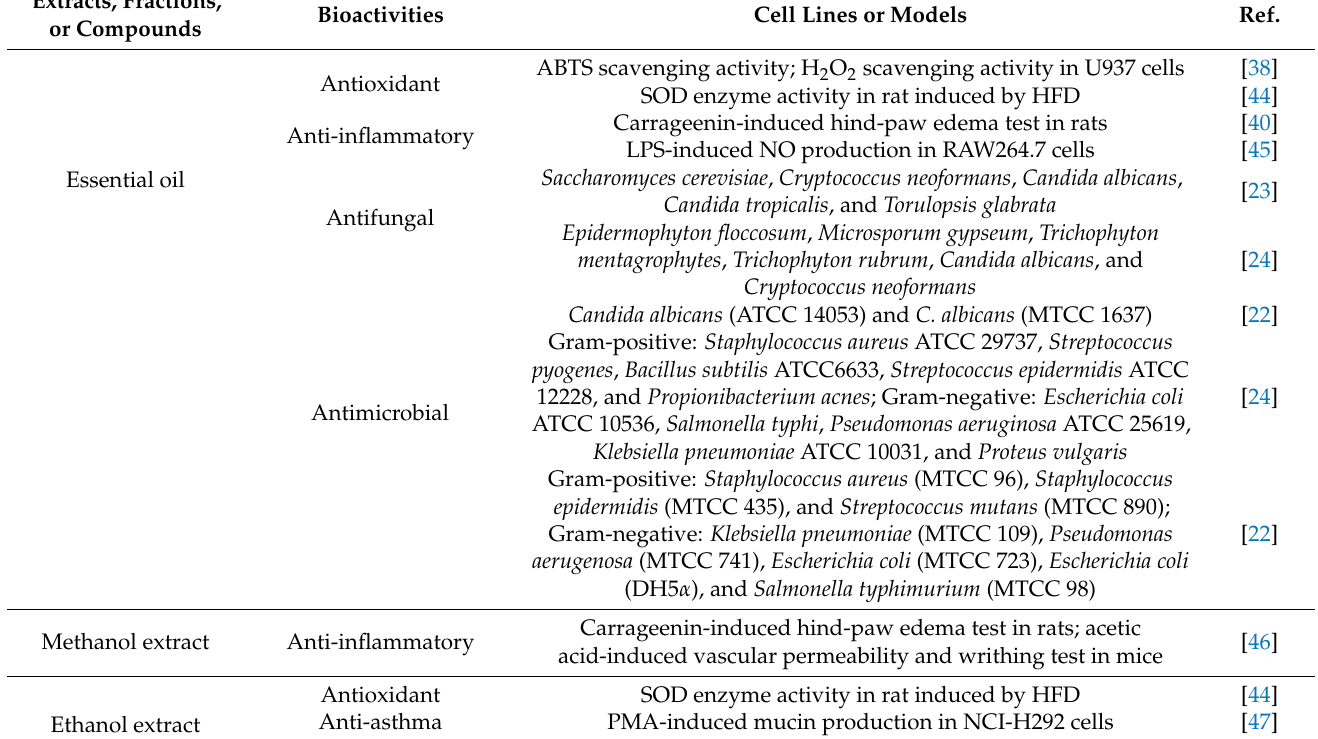
Table 1. Bioactivities of extracts, fractions, and constituents of Z. cassumunar . Extracts,